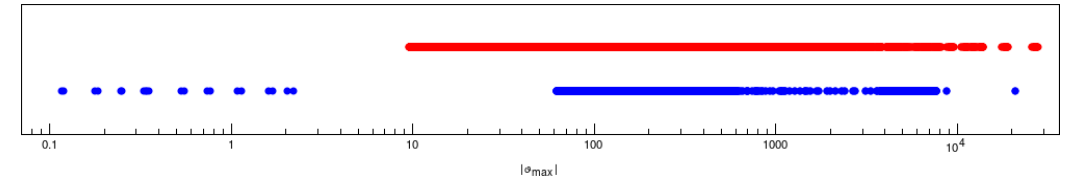
Figure 3 . Distribution of the largest eigenvalues # of the stability matrix of the (cid:12)xed points max of the colorless models. Blue dots: eigenvalues for the Y -independent solutions: there is a gap between 2.21 and 62.6. Red dots: eigenvalues for the Y -dependent solutions: there is no gap, the eigenvalues start around 10.